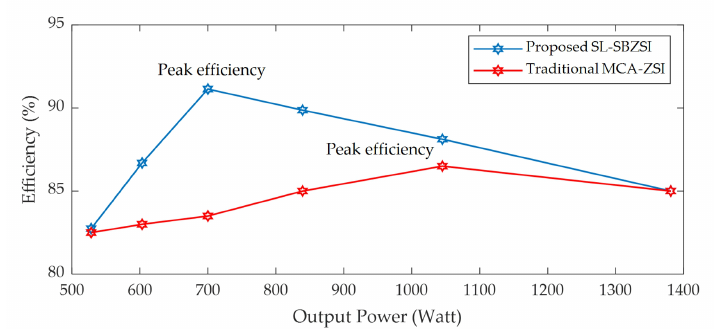
Figure 9. Efficiency curves.